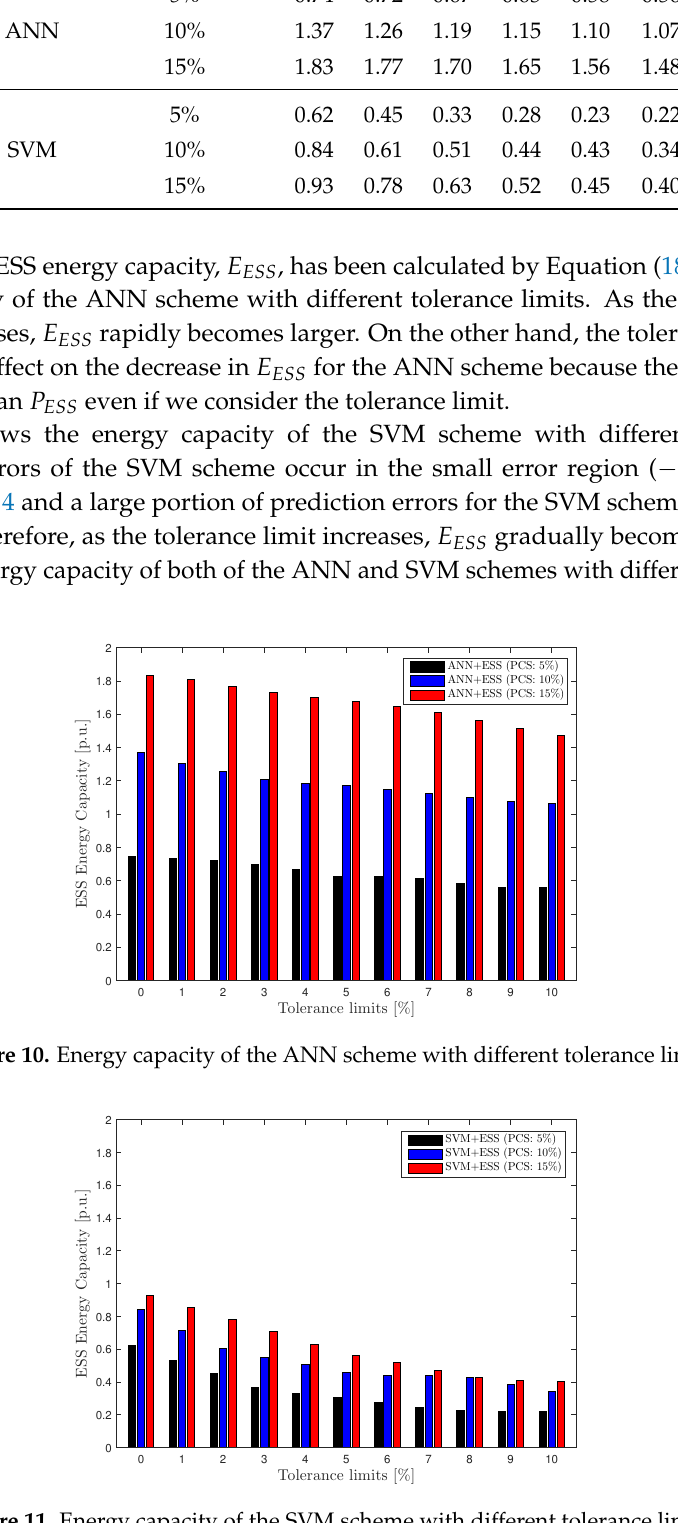
Figure 11. Energy capacity of the SVM scheme with different tolerance